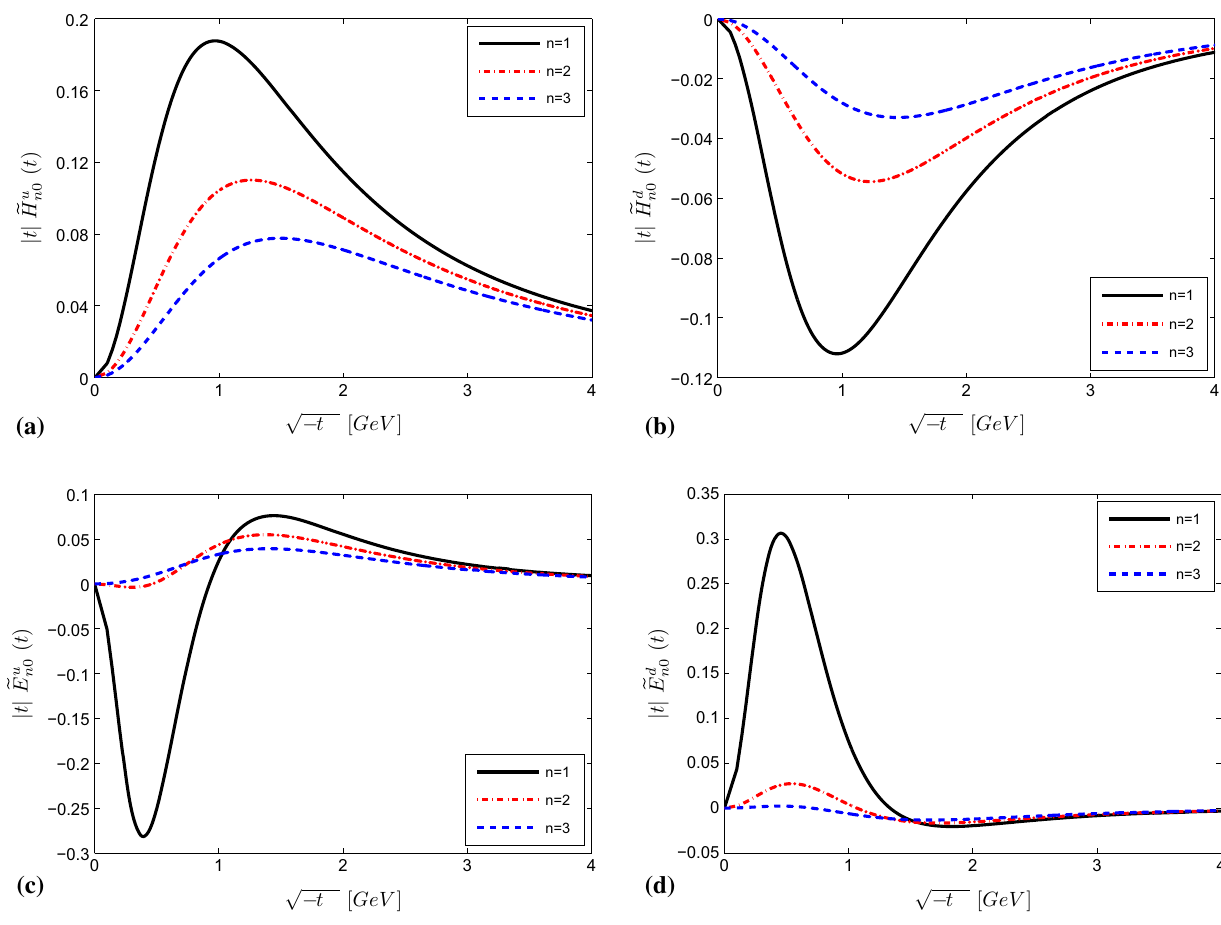
√ − t in GeV. The left panel is for the u